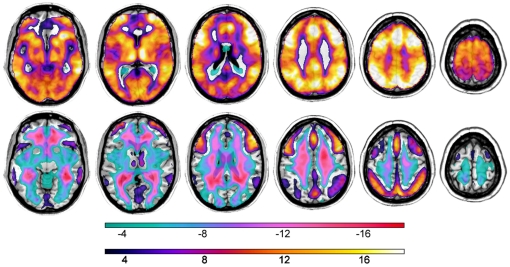
Influence of Noise Regression Methods on Connectivity Patterns.Functional connectivity group results (using one sample t-tests) with respect to the right DLPFC for the “standard implementation” of the connectivity analysis (top) and the additional global signal correction by application of the global normalization procedure (bottom). Yellow-red: positive correlations with seed voxel, green-blue: negative correlations with seed voxel.